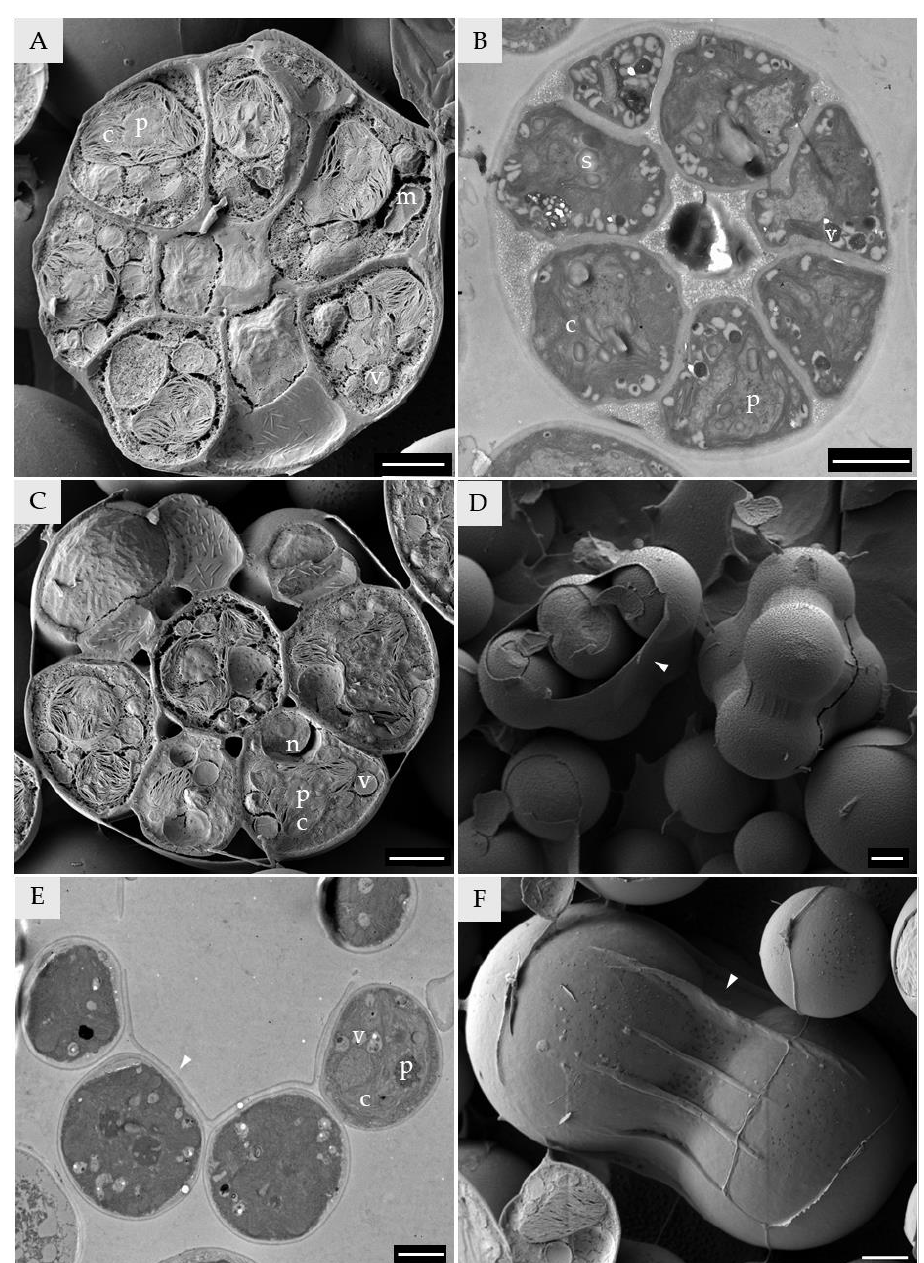
Figure 3. LTSEM ( A , C , D , F ) and TEM ( B , E ) of Trebouxia lynnae autosporangia. ( A , B ) Closed au- tosporangia. ( C ) Open autosporangia. ( D , E , F ) Vegetative cells inside the persistent autosporangium envelope. Chloroplast (c), pyrenoid (p), vesicles (v), starch grains (s), mitochondria (m), and nu- cleus (n) are indicated with letters. A persistent autosporangium envelope is indicated by a white arrowhead. Scale bars: ( A – F ) 2 µ